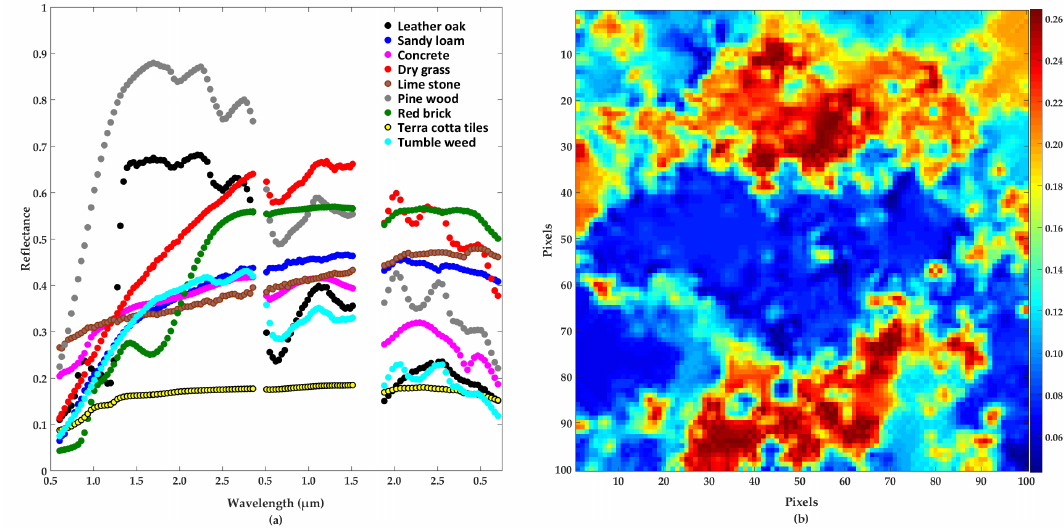
Figure 2. Spectral profiles of the endmembers ( a ) used to generate the synthetic vegetation image ( b ).